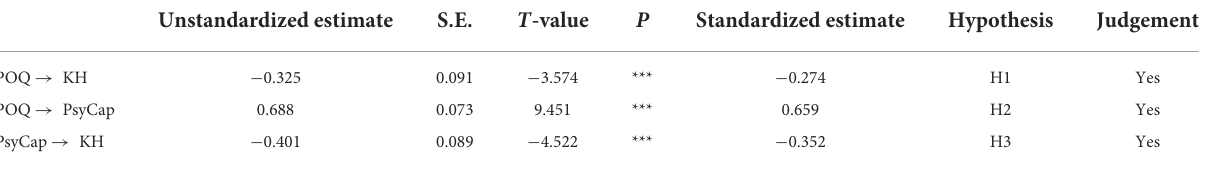
TABLE 5 Overall summary of structural models.